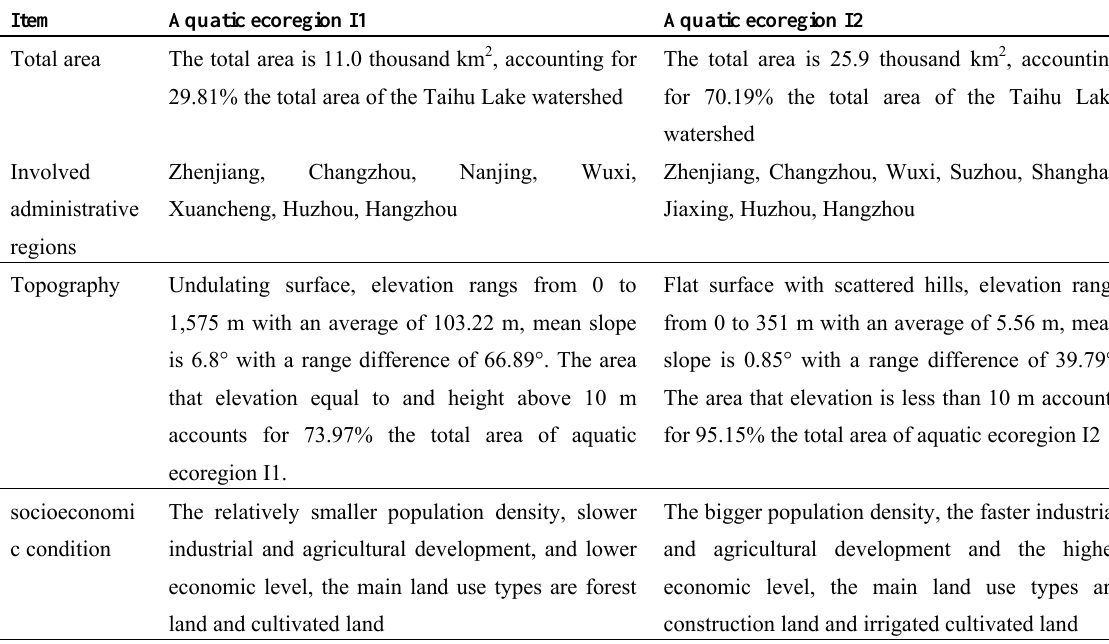
Table 2. General characteristics of the two level I aquatic ecoregions in Taihu Lake